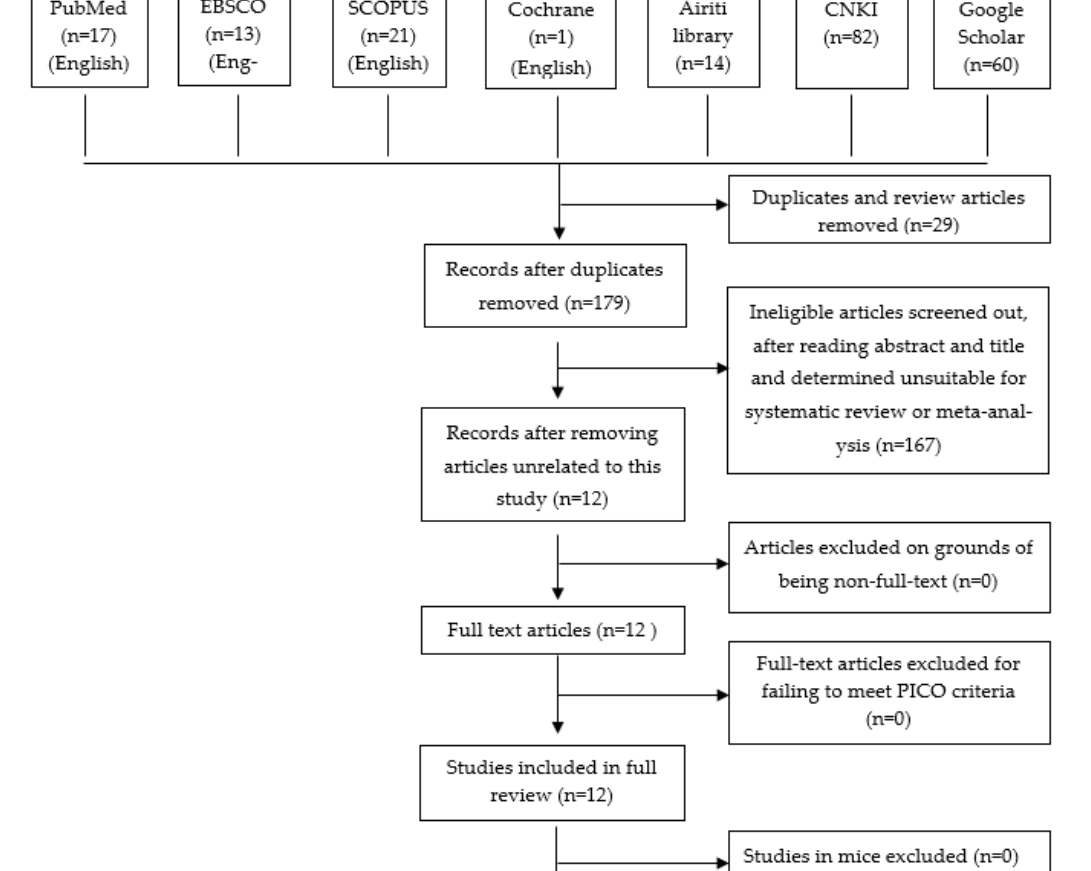
Table 1. System review of pu-erh tea anti-oxidative effect in rats.